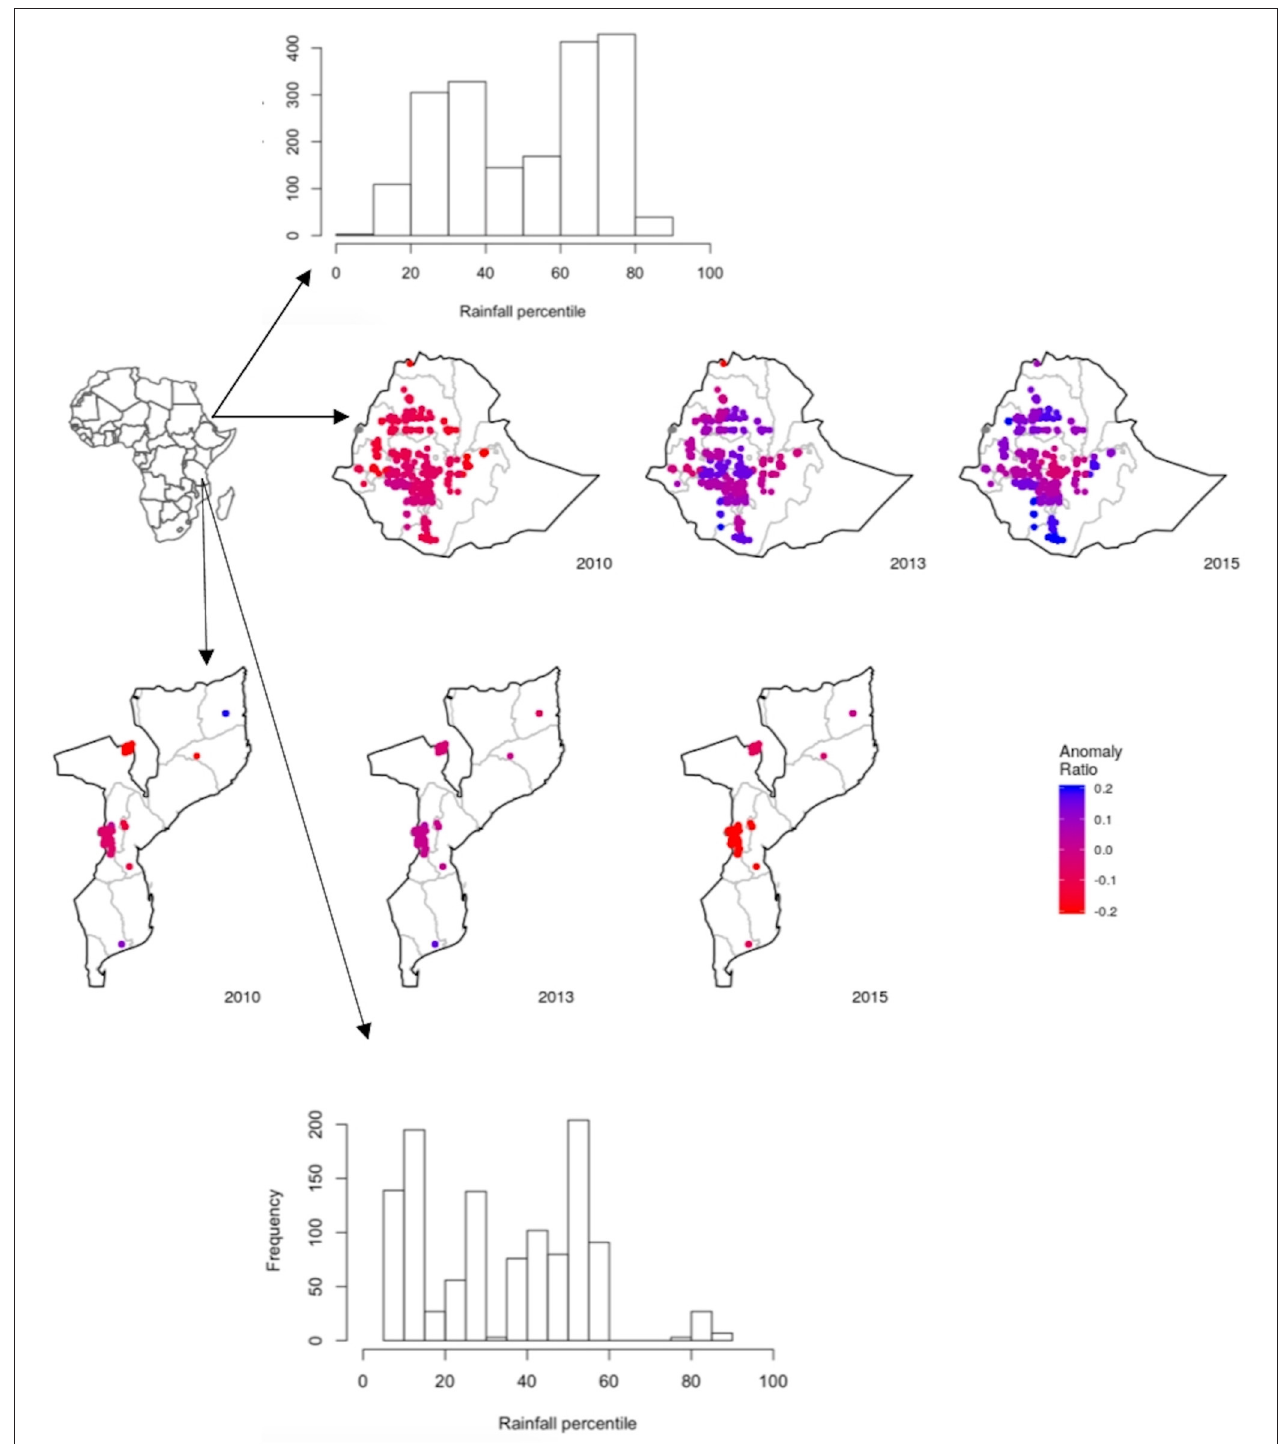
FIGURE 5 | Box plots of food sufficiency with (red) and without (grey) conservation agriculture (CA) practices across target groups in Ethiopia. The food requirement threshold for energetic needs (2100 kcal/CE/day) is indicated with a horizontal line. The food requirement threshold for protein needs (60 g/CE/day) is indicated with the vertical